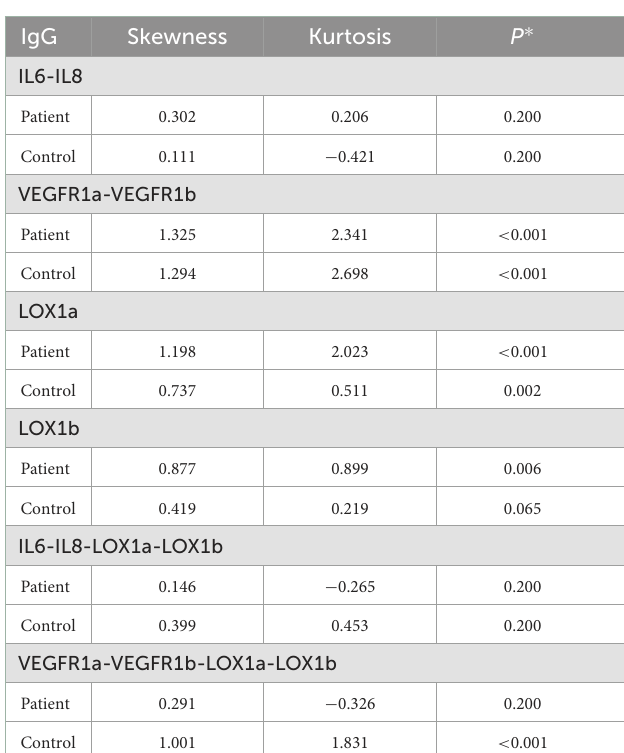
TABLE 2 The normal distribution test for plasma IgG levels in ischemic stroke cases and controls.